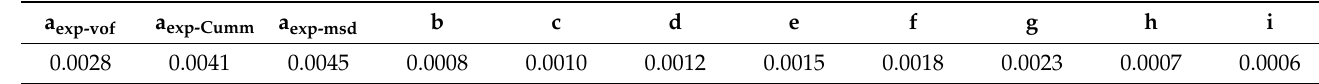
Table 3. Mean absolute differences between the curves plotted in Figure